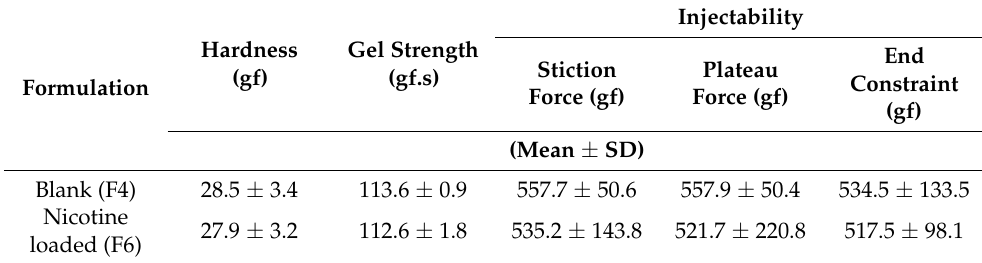
Table 7. Mechanical properties of the optimized formulations.